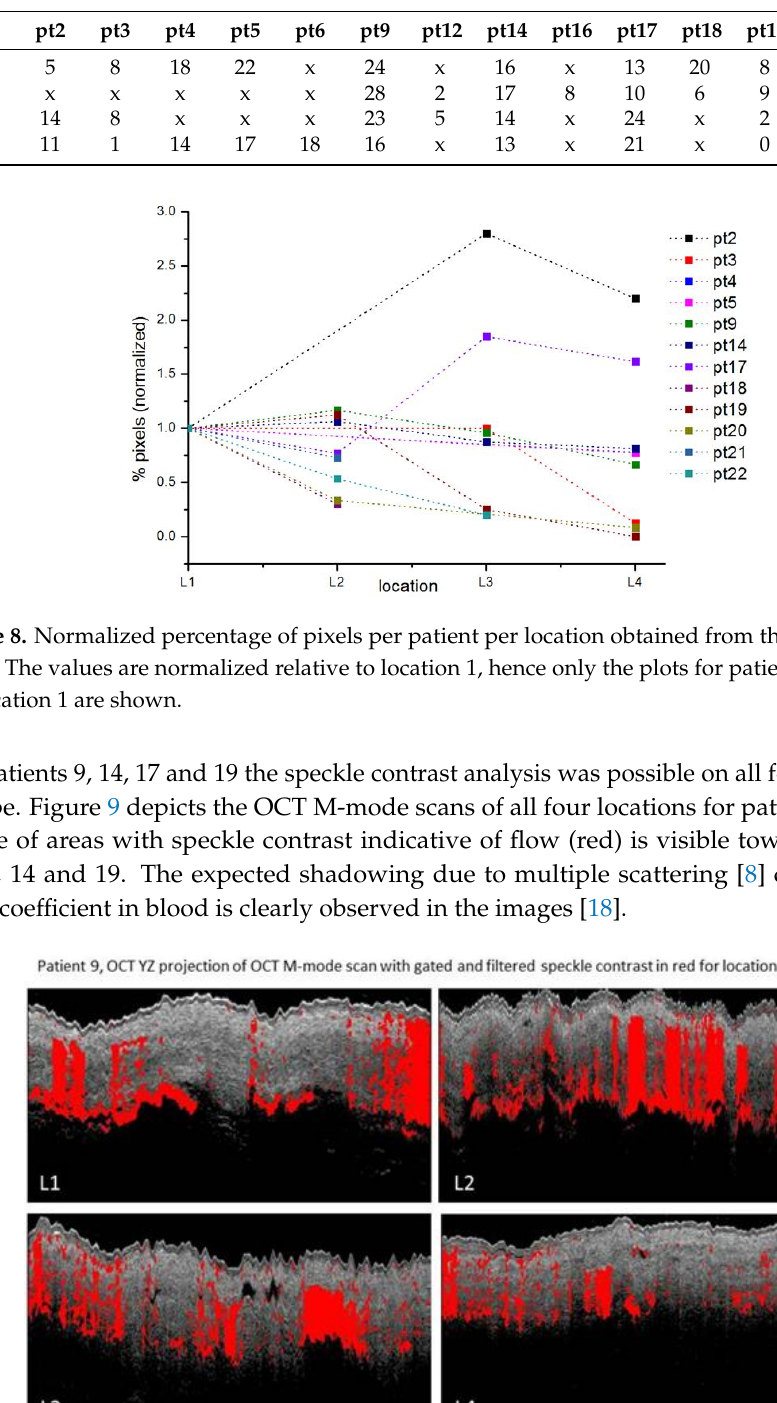
Table 1. Percentage of pixels indicative of flow per patient per location obtained from the OCT M ‐ mode scans. In red the flow in location 4 of the gastric tube.